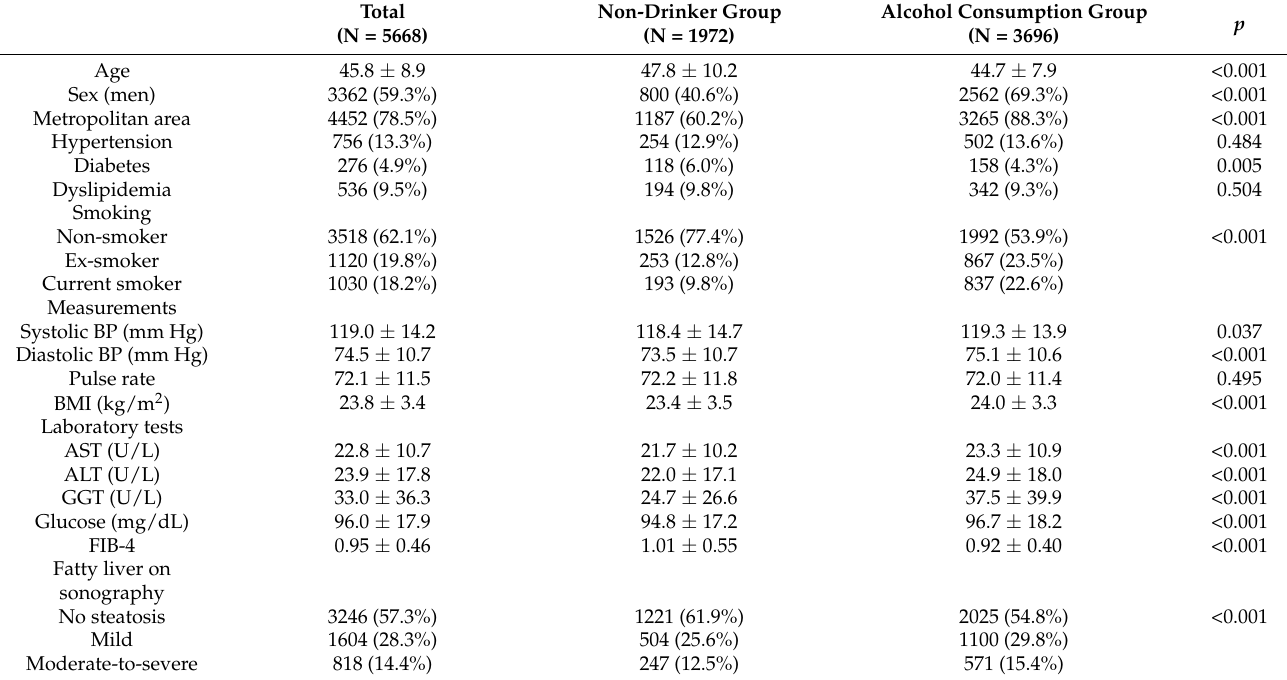
Table 1. Baseline characteristics of the subjects according to alcohol history.